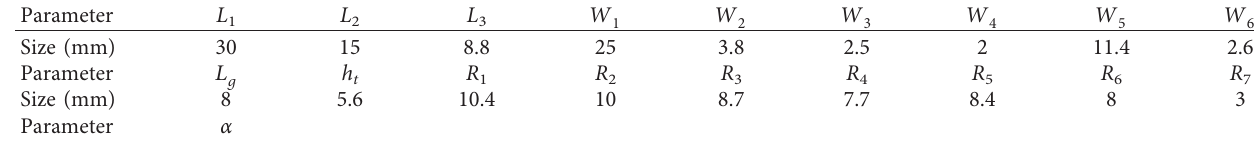
Table 1: The detailed dimensions of the proposed antenna.